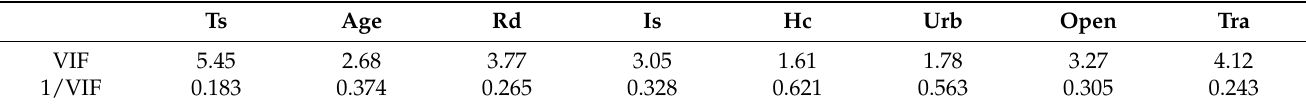
Table 2. The findings of the VIF test.